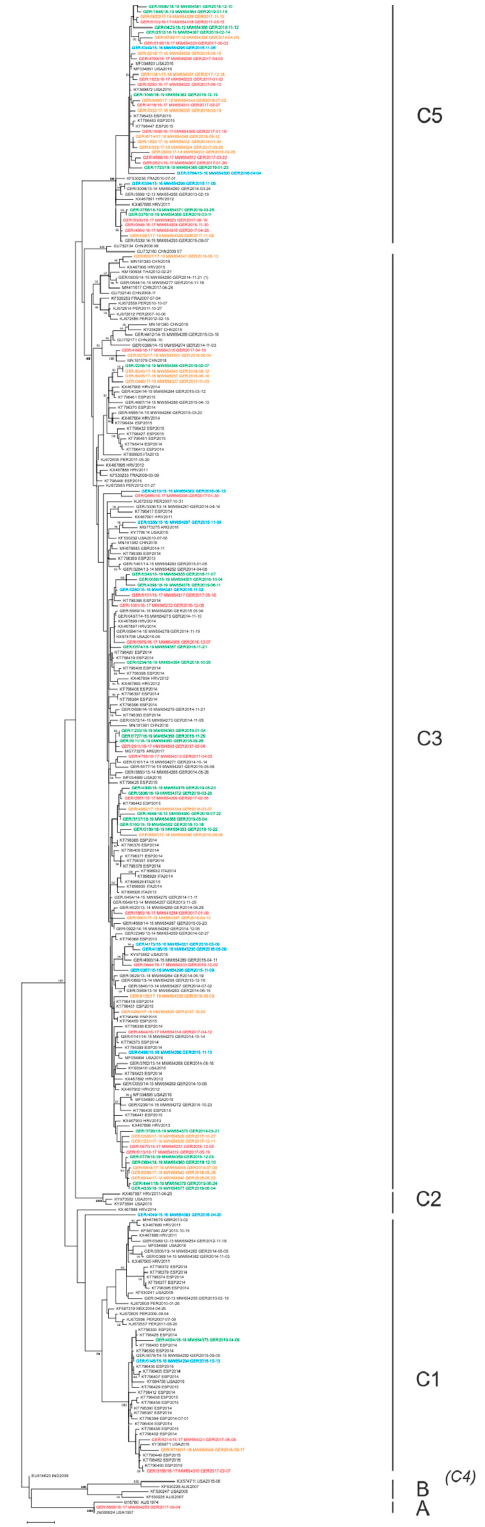
Figure 4. Maximum likelihood tree of the partial HN gene of HPIV-3. German sequences of this study are colored by epidemic season: 2015/16 in blue, 2016/17 in red, 2017/18 in orange, and 2018/19 in green. Clades are indicated on the right. Only bootstrap values ≥ 80% are displayed at the branch